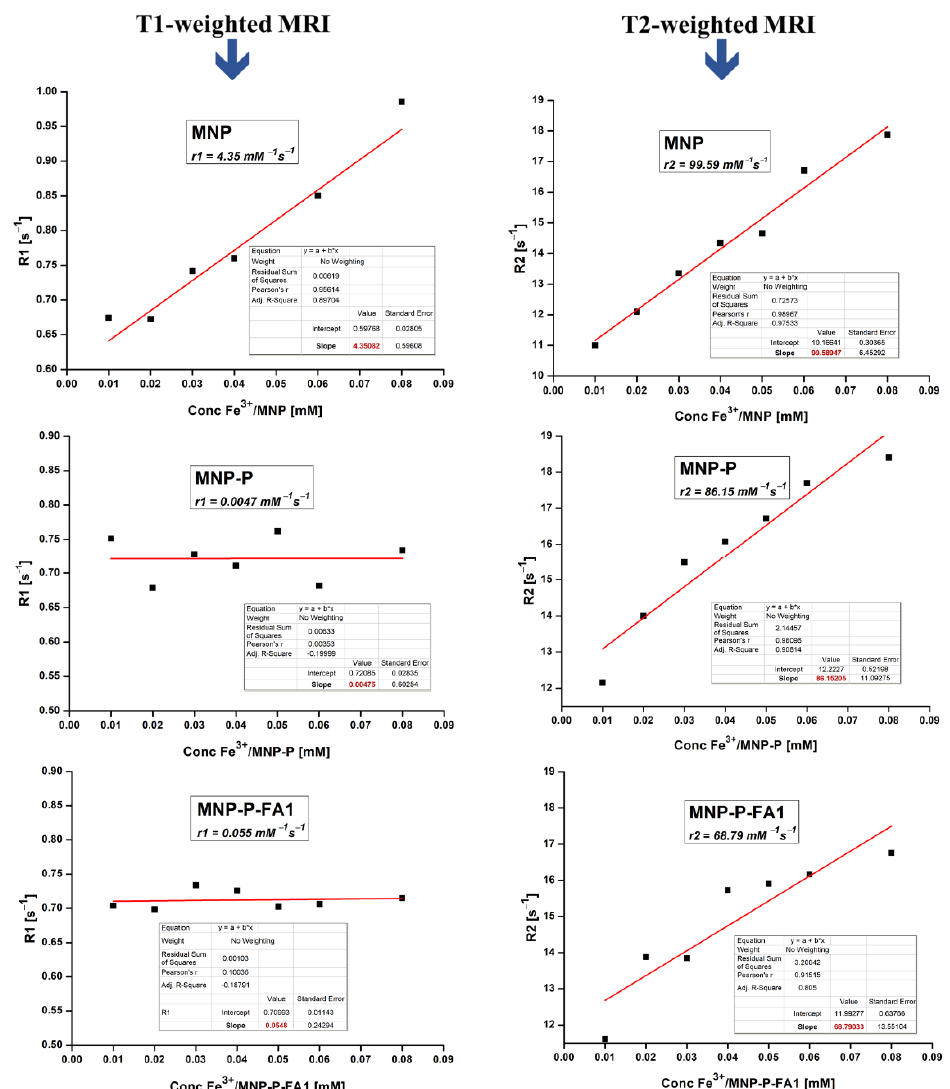
Figure 12. Linear fitting of 1/T1 (left column) and 1/T2 (right column) for MNP (first line), MNP-P (middle line) and MNP-P-FA1 (bottom line) as a function of [Fe 3+ ].